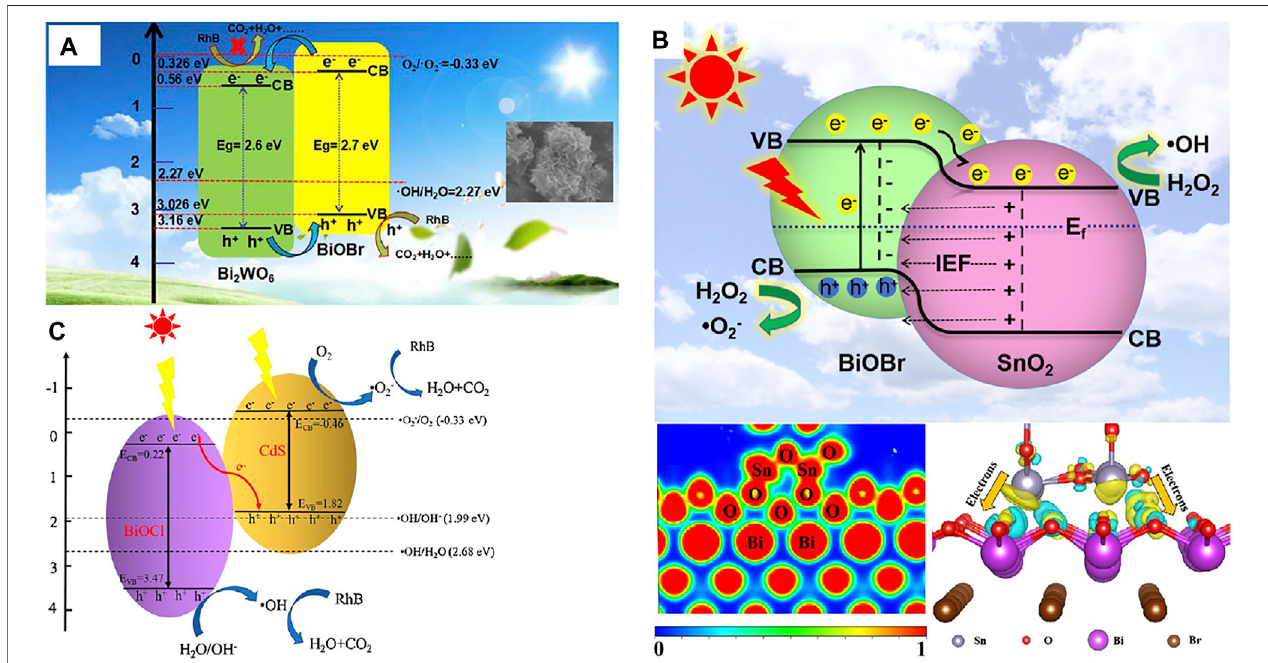
FIGURE 6 | (A) Photocatalytic mechanism of pollution by Bi 2 WO 6 /BiOBr catalyst (Type II heterojunction) (Ren et al., 2019). (B) Diagram of BiOBr/SnO 2 p-n heterojunctionchargetransferattheinterface,electronlocationfunction,andchargedifferencedistribution(Wuetal.,2020); (C) ChargetransferinZ-schemeCdS/BiOCl catalyst (Tang et al.,